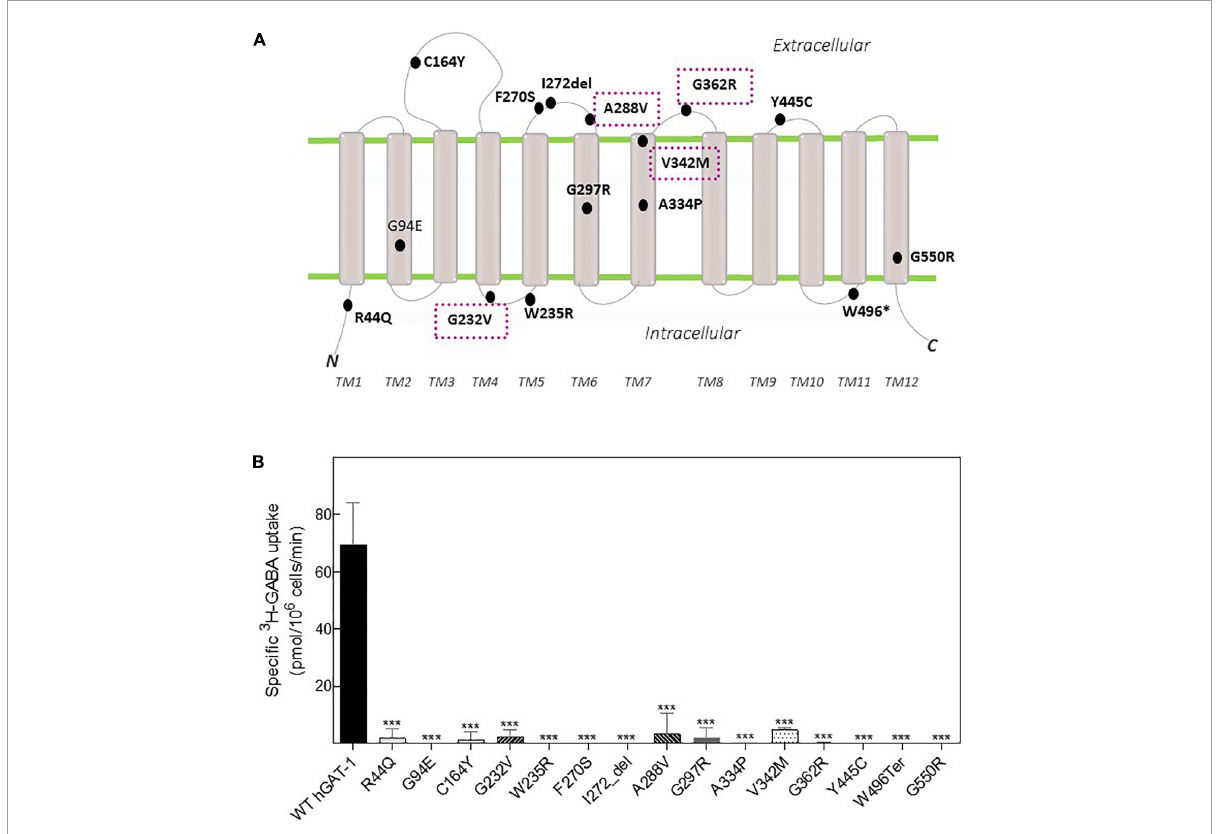
FIGURE1 Topology model and GABA transport activity of human GABA transporter 1 (GAT-1) variants linked to epilepsy. (A) Epilepsy variants mapped onto the hGAT-1 topology, indicating their respective positions. Four recurrent variants are encapsulated (dotted boxes). N and C, amino and carboxyl termini, respectively; TM, transmembrane domains; “*”and “del,” termination codon and deletion mutations, respectively. (B) HEK293 cell were transfected with plasmids encoding yellow fluorescent protein (YFP)-tagged hGAT-1 plasmids encoding the indicated mutations and wild type hGAT-1 as control. Specific [ 3 H]GABA uptake was measured for exactly 3 min, as described in “2 Materials and methods”. Non-specific uptake was determined in the presence of 10 µ M tiagabine. Error bars indicate S.E.M. The data were statistically analyzed by one-way ANOVA, followed by Tukey’s post-hoc t -tests [*** P < 0.001, compared to WT hGAT-1